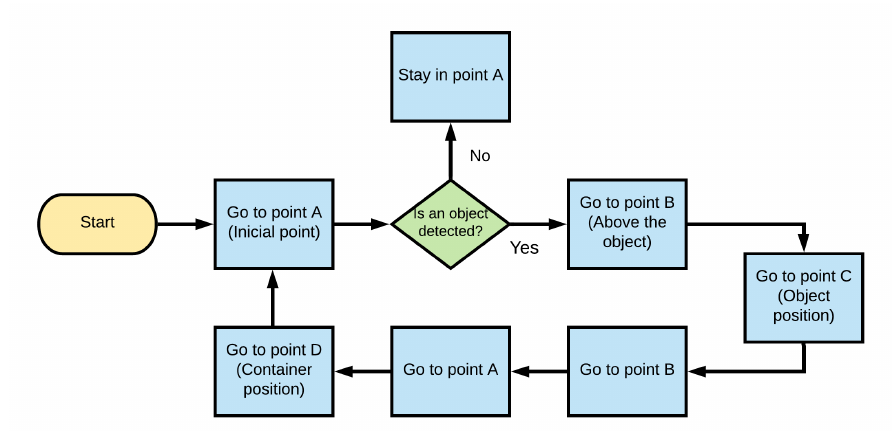
Figure 9. Trajectory planning to move the end-effector.